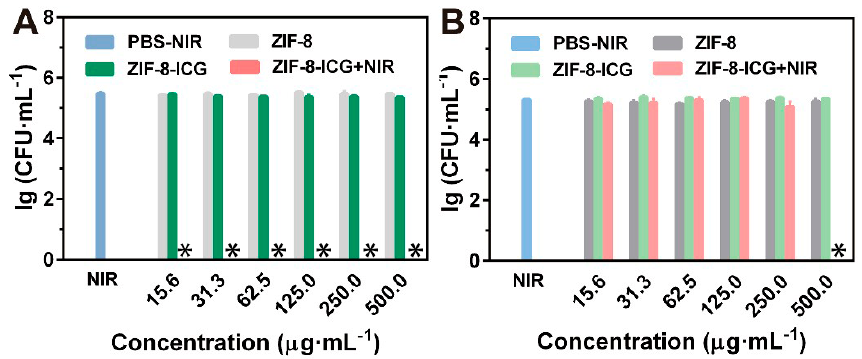
Figure A1. Bacteria viabilities of ( a ) MRSA and ( b ) P. aeruginosa with different treatments ( ∗ denotes no colonies were observed).